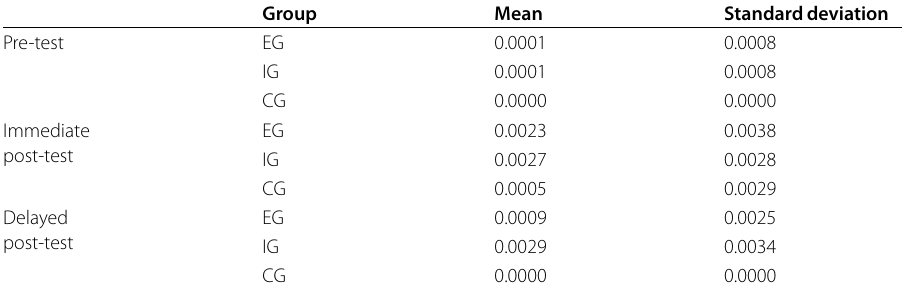
Table 7 Descriptive statistics for questions (normalized values) Group